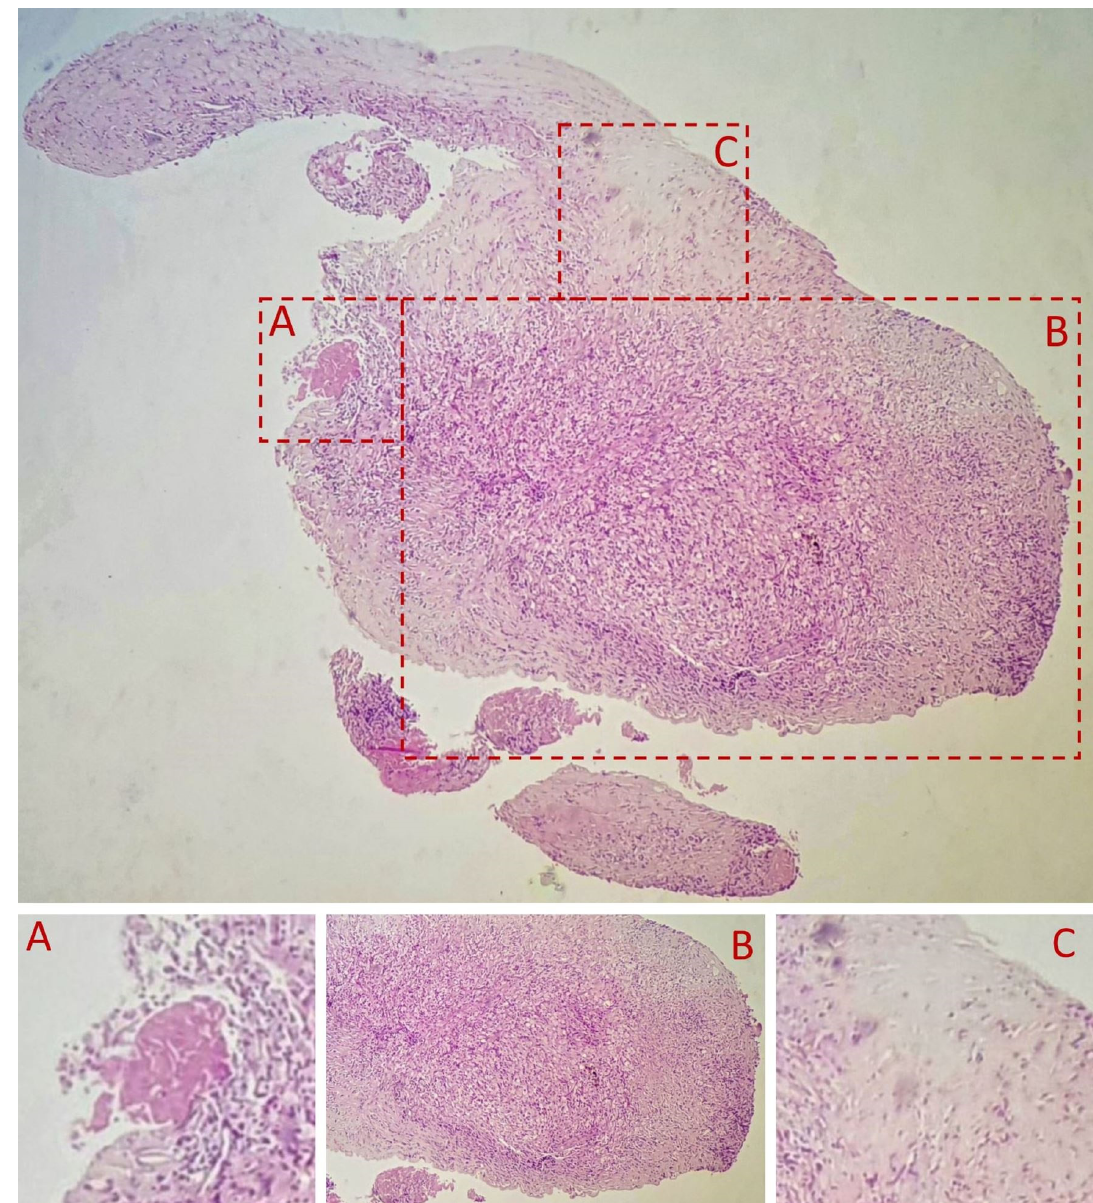
Figure 3. HE stain, 4×. ( A ) indicates a resection artifact. ( B ) The inflammatory infiltrate of foamy macrophages and lymphoplasmacytic elements. ( C ) indicates an abundance of immature collagen fibers .